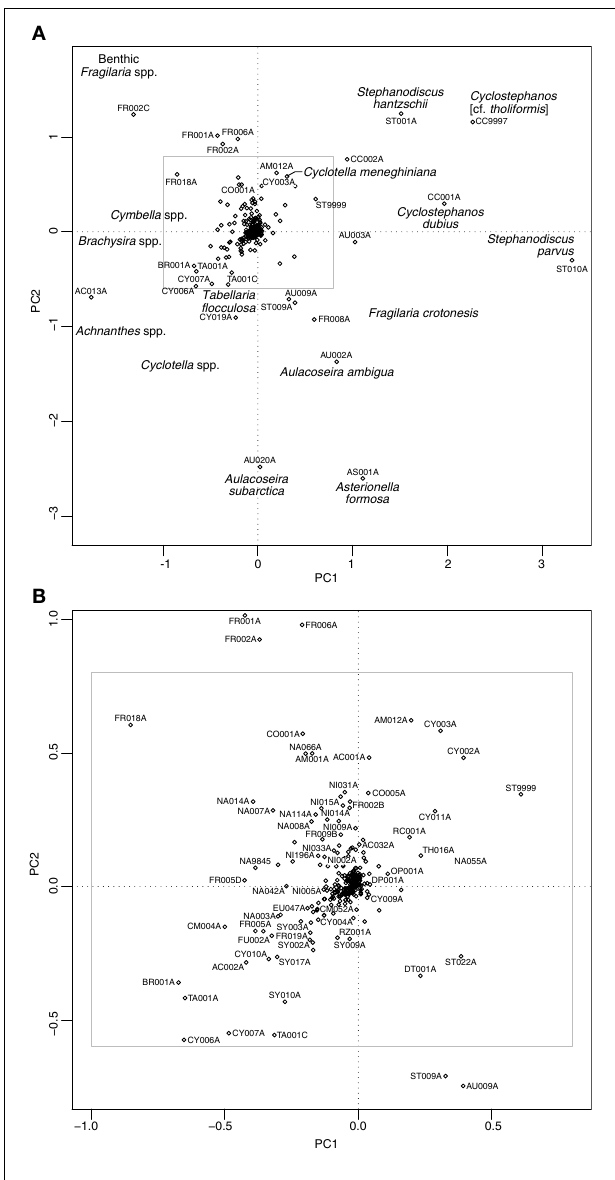
FIGURE 9 | Species plot on a PCA of training set samples for the shallow lake cores. (A) All taxa present in at least five sites and with maximum abundance greater than or equal to 5%, (B) zoomed in section as indicated by the inset in (A) . See Supplementary Material, Appendix 1 for diatom codes and